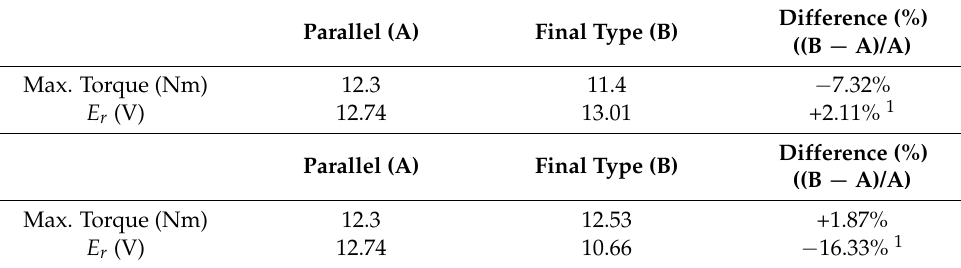
Table 7. Comparison of maximum torque and E r between final type and parallel